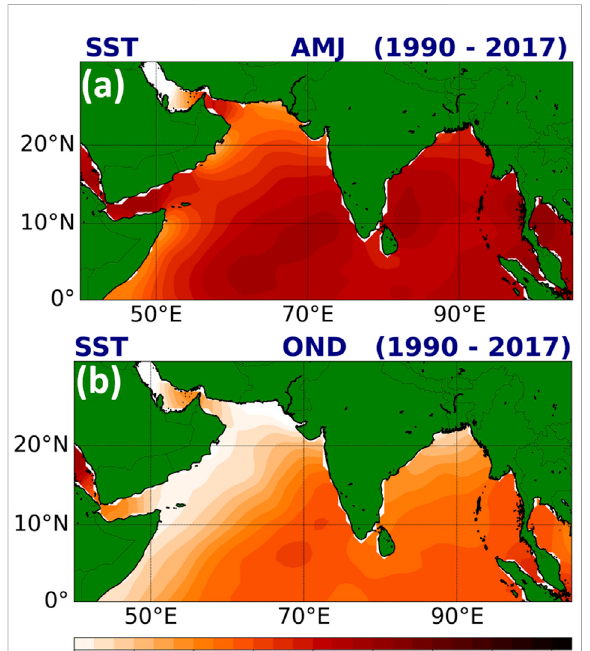
FIGURE 5 The mean SST ( o C) over the NIO during 1990 – 2017 for (A) April-June (AMJ) and (B) October-December (OND). The SST data was obtained from Hadley Centre Global Sea Ice and Sea Surface Temperature dataset.